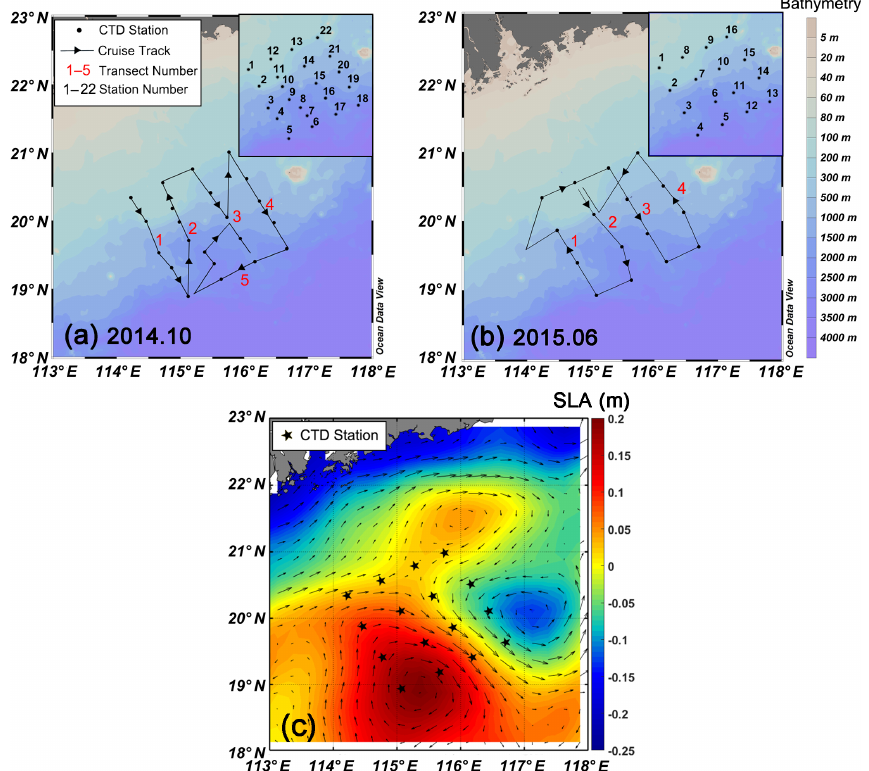
Figure 1. Cruise tracks of two cruises in the slope region of the northern South China Sea in (a) October 2014 and (b) June 2015. The sea level height anomaly (SLA) and geostrophic current during observations in June 2015 (Chen et al., 2016) are shown in (c) . The black dots and stars represent the locations of the CTD casts. Red numbers indicate transects, while black numbers indicate the serial number of CTD stations based on the cruise plan. The color scale in (a) and (b) represents